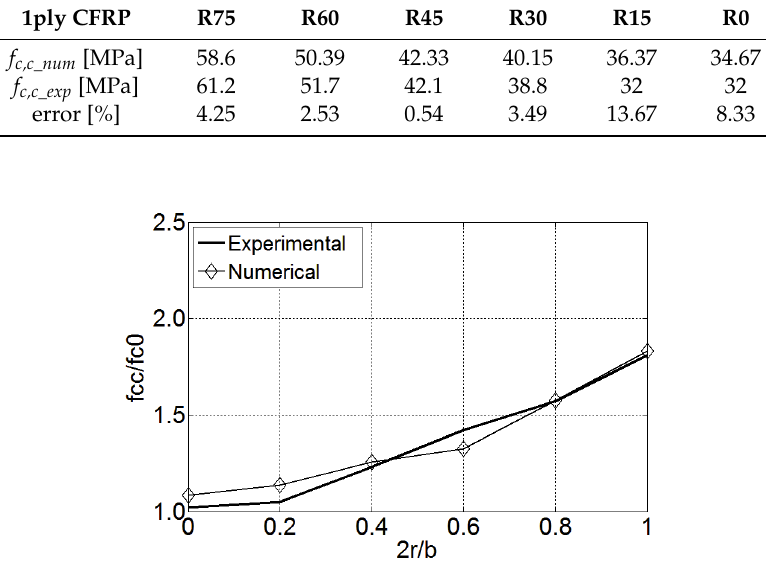
Figure 9. Variation of the strength of 1ply CFRP-columns with the corner radius (normalized values) .